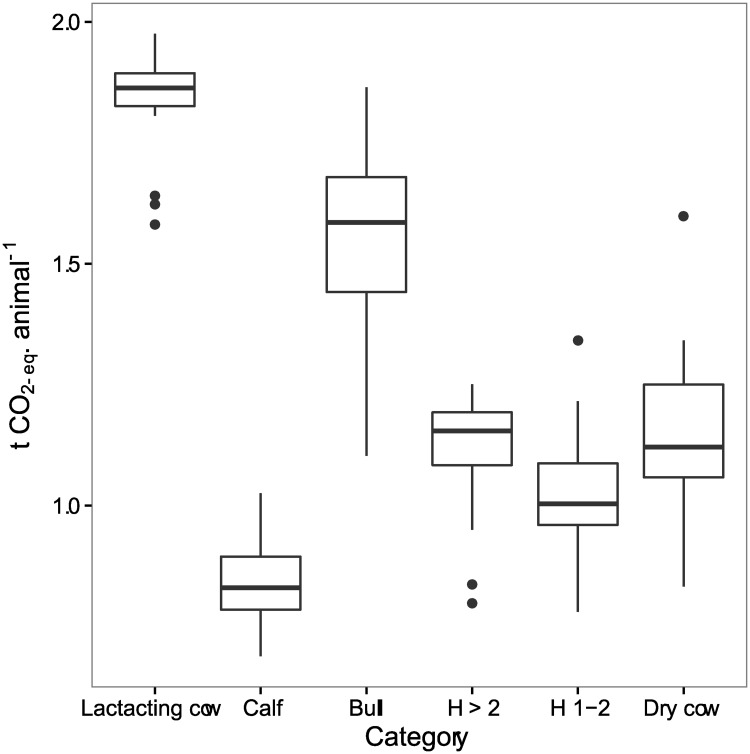
Mean GHG emissions (n = 30) from milk production in a. dry season and b. wet season.Sources are methane from enteric fermentation (CH4E.F), methane from manure (CH4M.R) and nitrous oxide from manure (N2OM.R).